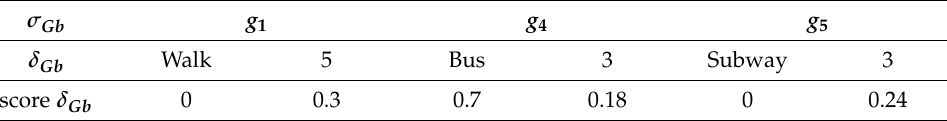
Table 9. Scores for the sub-sequence σ Gb .